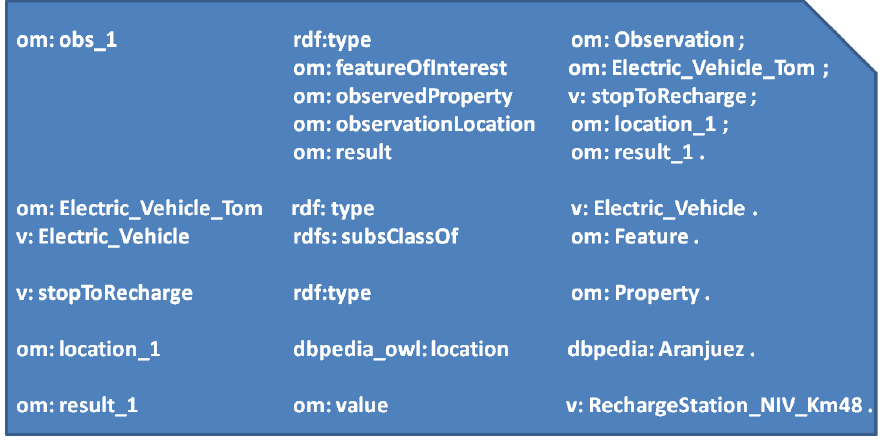
Figure 5. Example of an Electric Vehicle observation using